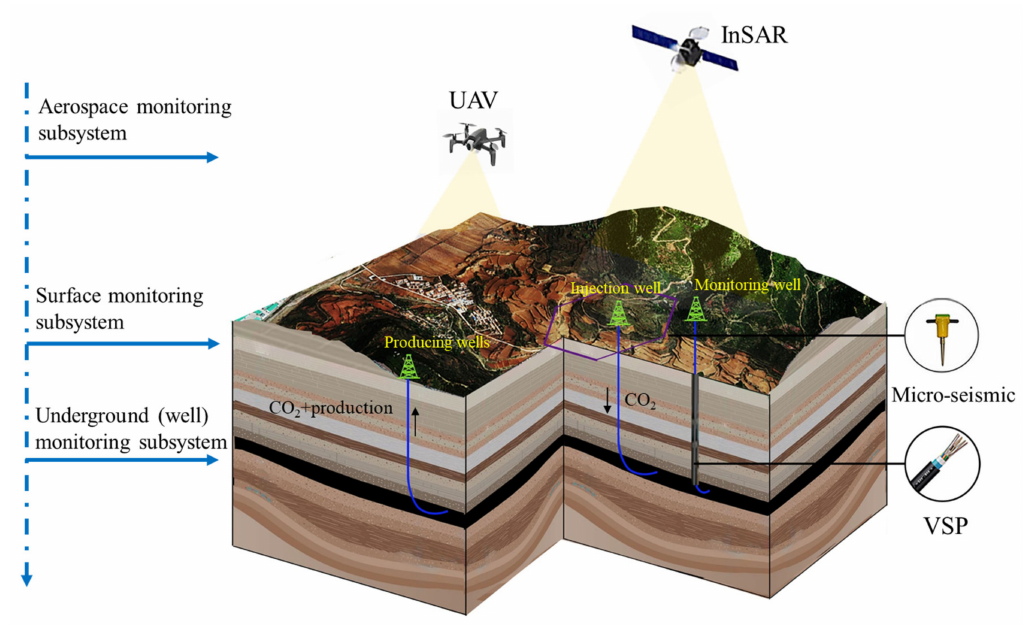
Figure 5. A multi-method monitoring